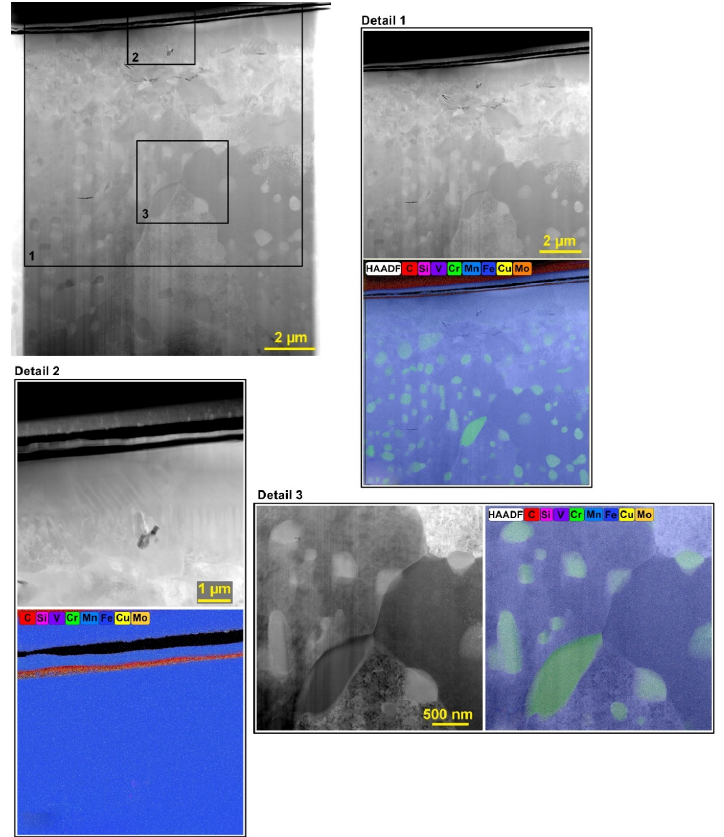
Figure 9. Lamella of Sample 65 of steel 1.2343ESR (electrode material: graphite, electrode shape 100 mm × 100 mm) together with three different details where the chemical composition analysis was performed. Table 5. Analysis of the chemical composition in each detail according to Figure 9.